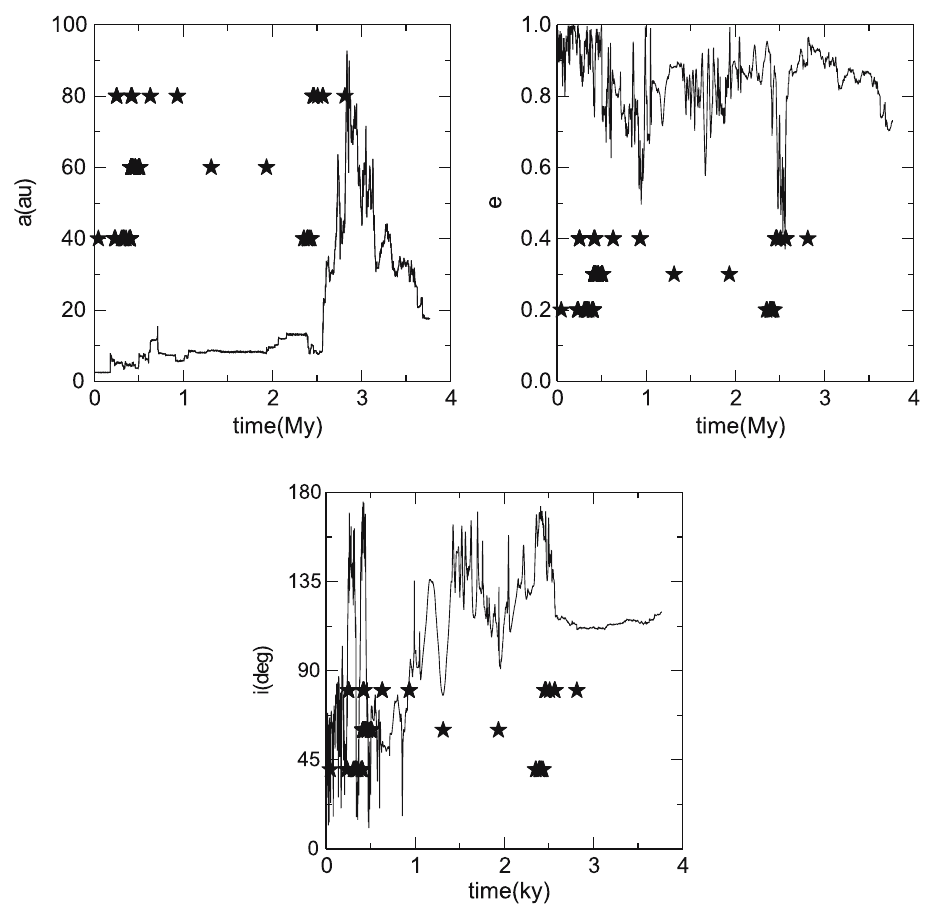
Figure 7: Forward orbital evolution of the clone # 44 of the comet 322P without NG e ff ects with the longest time on the retrograde